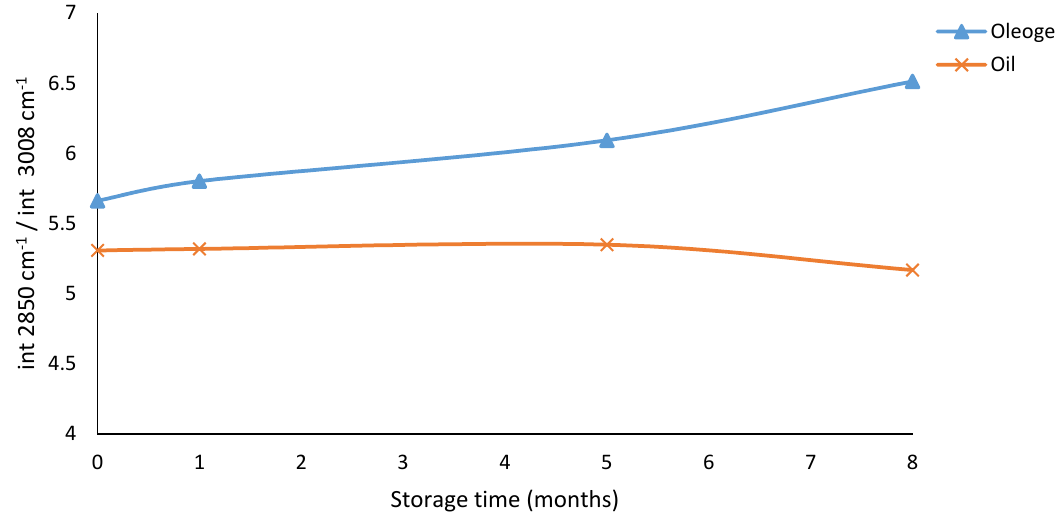
Figure 4. Ratio of intensities 2850 cm − 1 / 3008 cm − 1 of the oil and oleogel samples during storage.